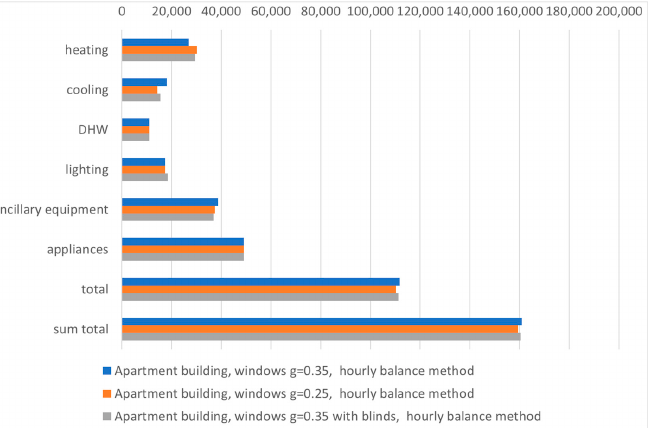
Figure 17. The final energy demand of glazings and windows with and without solar blinds for the residential building. Energies 2021 , 14 , x